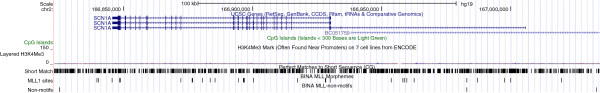
Human genomic DNA without a CGI. Track labeled “Short Match” marks the position of CpGs. Track-labeled “MLL1 sites” marks morpheme positions; “non-motifs” mark the position of sequences not found in results of SELEX assays [24]. Track labeled “Layered H3K4me3” shows the position of H3K4me3 marks.